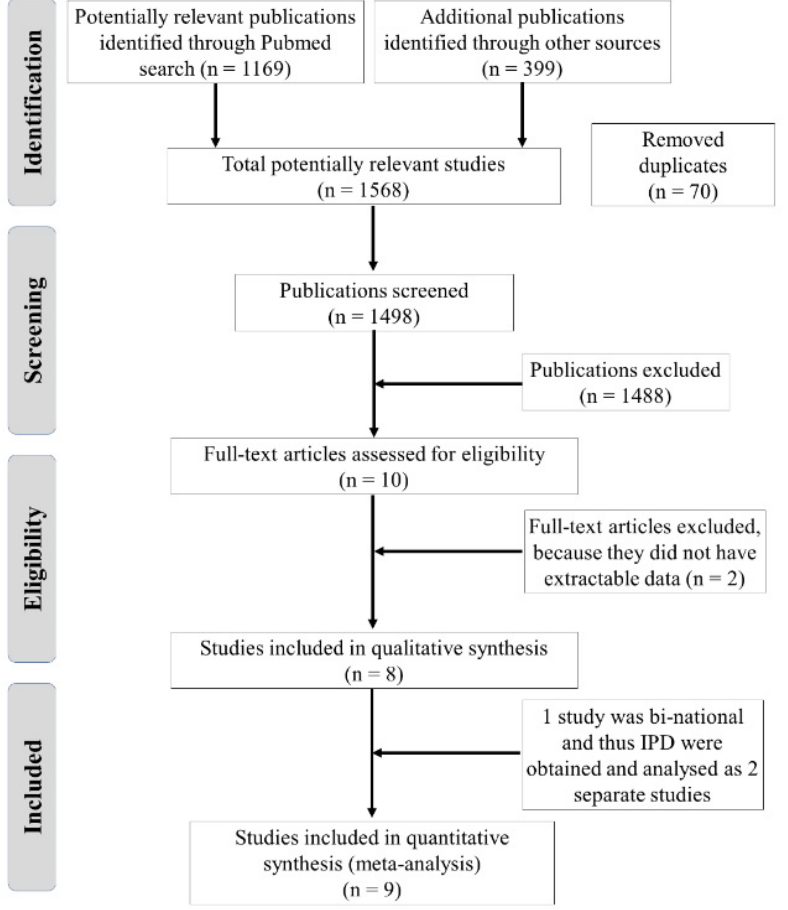
Figure 1. Overview of the study search and selection.